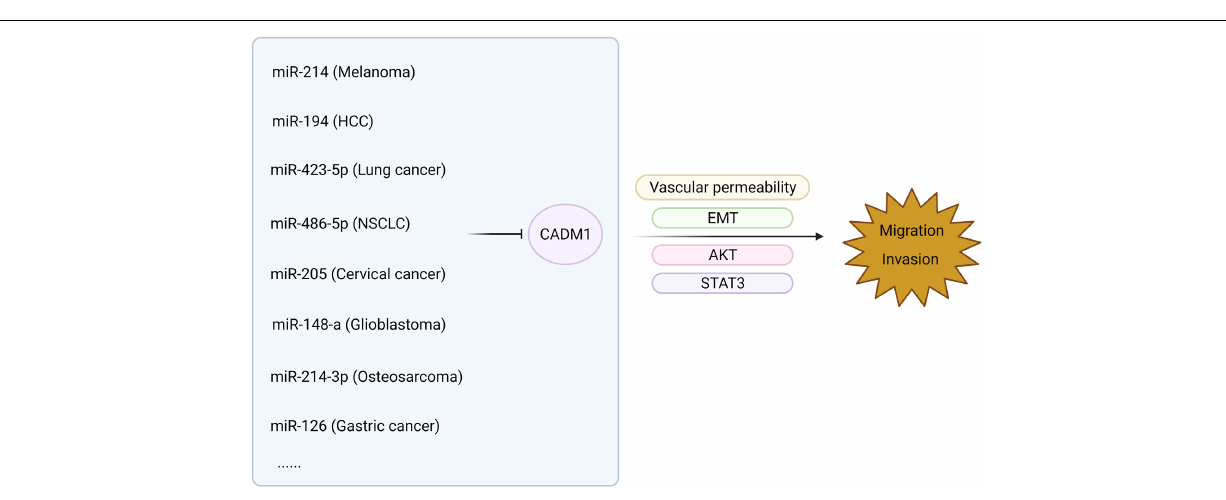
FIGURE 4 | MiRNAs are involved in the metastasis of malignant tumors by acting on CADM1 in multiple systems.